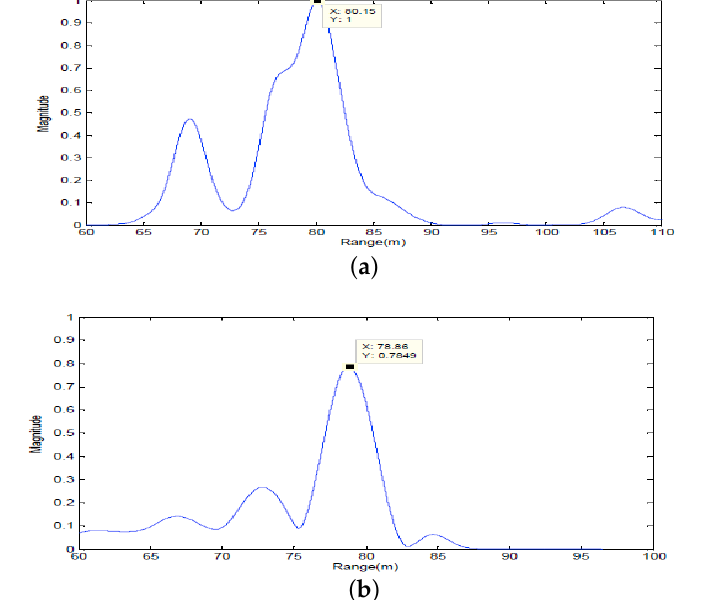
Figure 16. The outputs of the replica correlation integration processer with PCW signals: ( a ) the distributed TR-MIMO sonar system; ( b ) the distributed phased-MIMO sonar system. Note that the outputs are normalized by the maximum value of outputs of the distributed TR-MIMO sonar